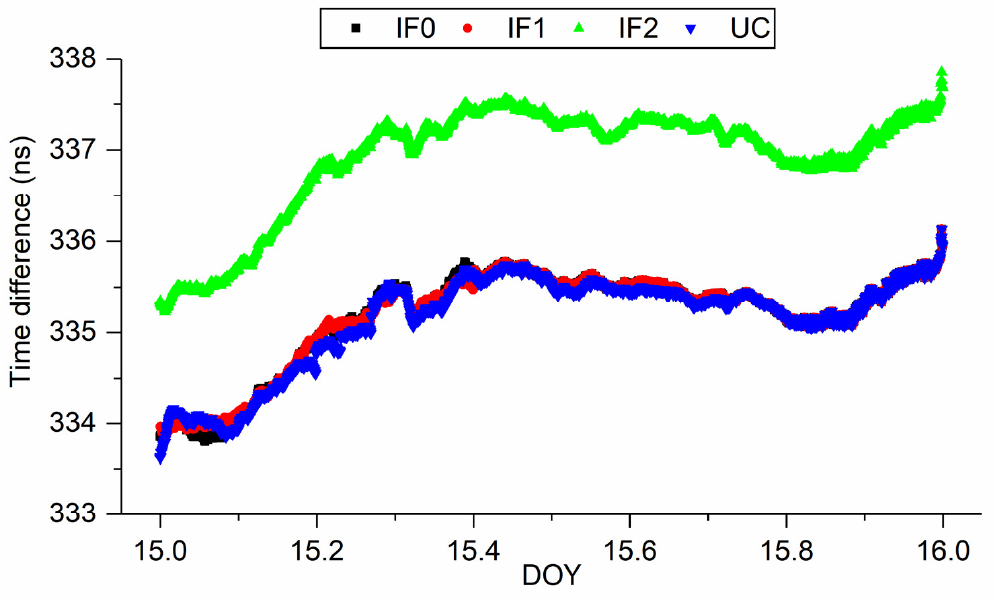
Figure 4. Comparison of time difference of XIA3-BRCH obtained from different models on DOY 15, 2019.